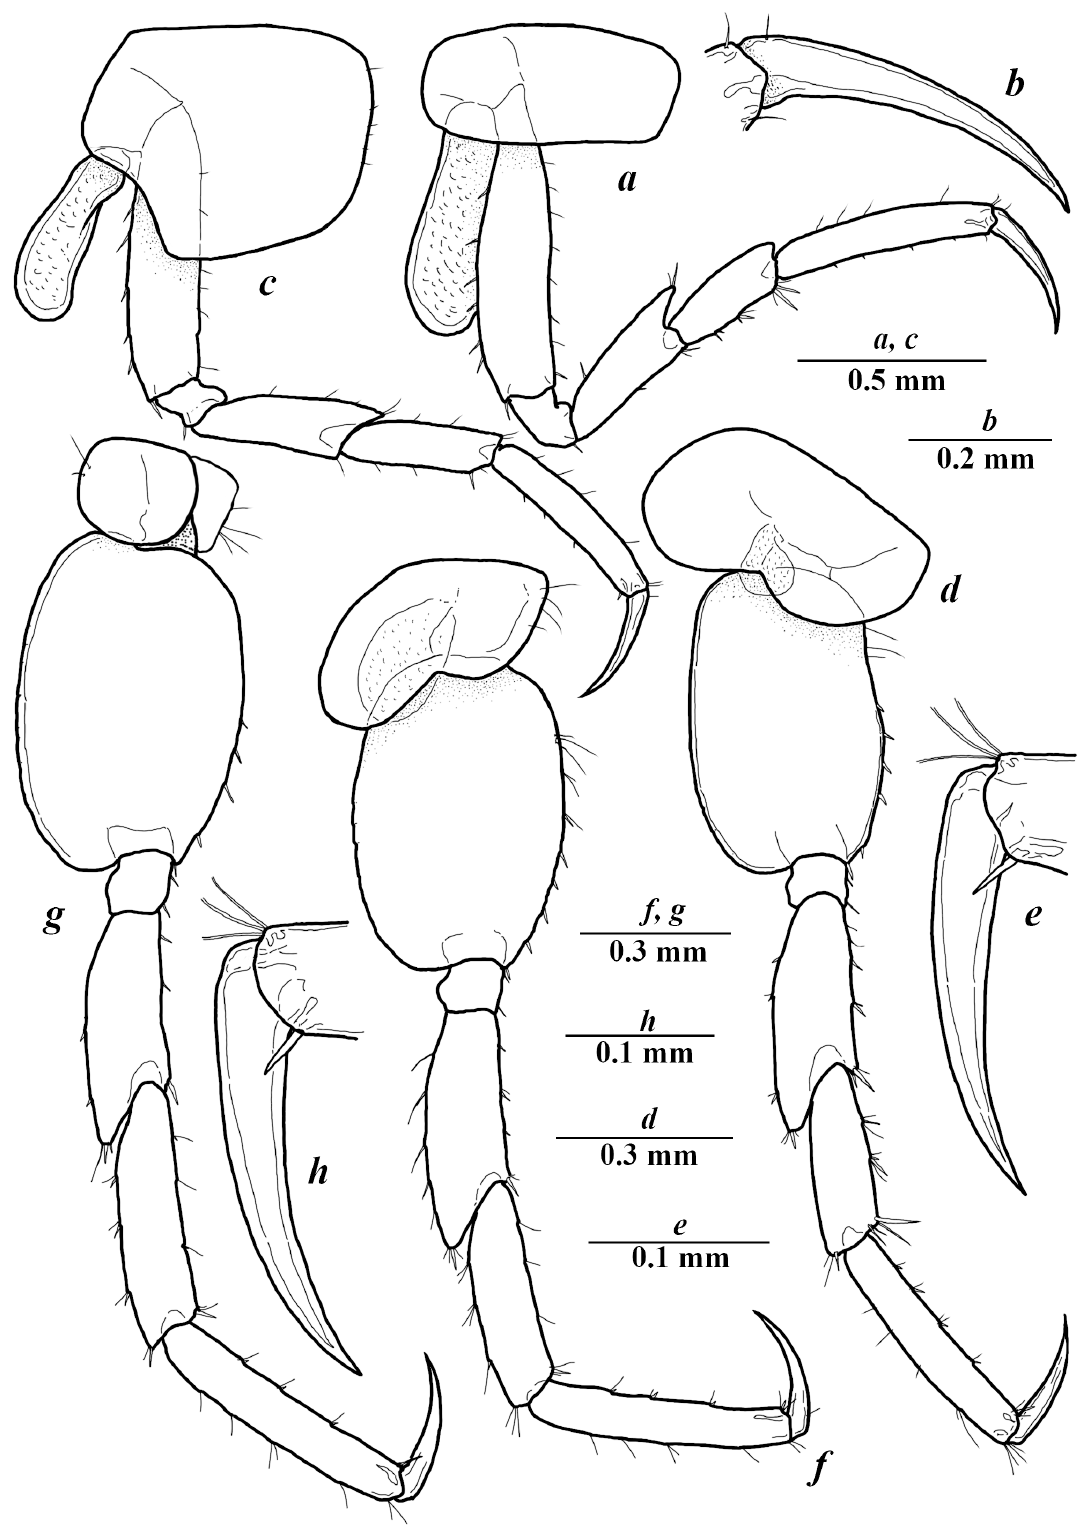
Fig. 4. Pleusymtes actiniae sp. nov., paratype, ♀ (ZMMU Mb-1224). a . Pereopod III. b . Dactylus of PIII. c . Pereopod IV. d . Pereopod V. e . Dactylus of PV. f . Pereopod VI. g . Pereopod VII. h . Dactylus of